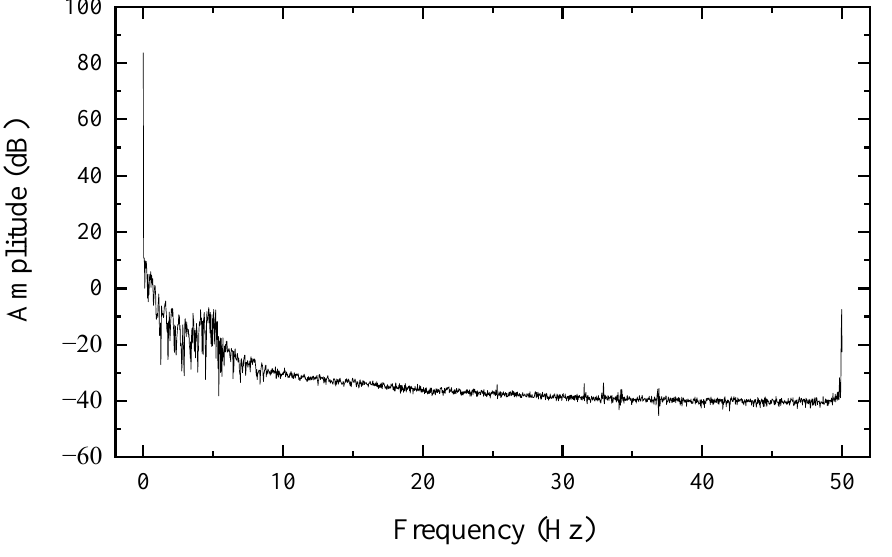
Figure 12. Fast Fourier expansion of the environmental magnetic field in the z-axis direction.